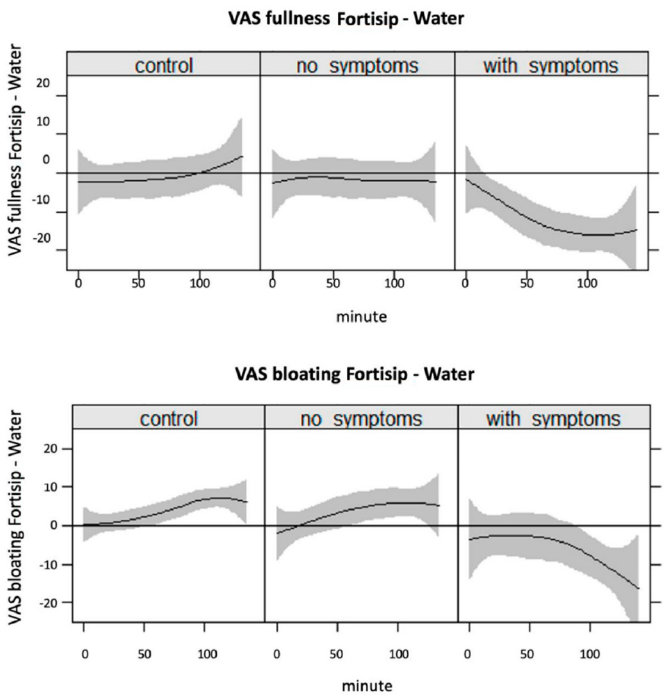
Figure 3. Variation in symptoms between individuals is large. For this reason, this figure presents the difference in postprandial symptom severity following ingestion of the oral test meal after jeju- nal infusion with liquid nutrient (JN) and placebo (water) with 95% confidence bands. Negative values represent a reduction in symptoms after the nutritional intervention. Healthy controls (HV) and diabetic controls without symptoms (DC) reported similar or non-significantly higher postpran- dial symptom scores if JN had been delivered prior to the meal. In contrast, DG patients had signif- icantly less postprandial fullness, bloating and pain.